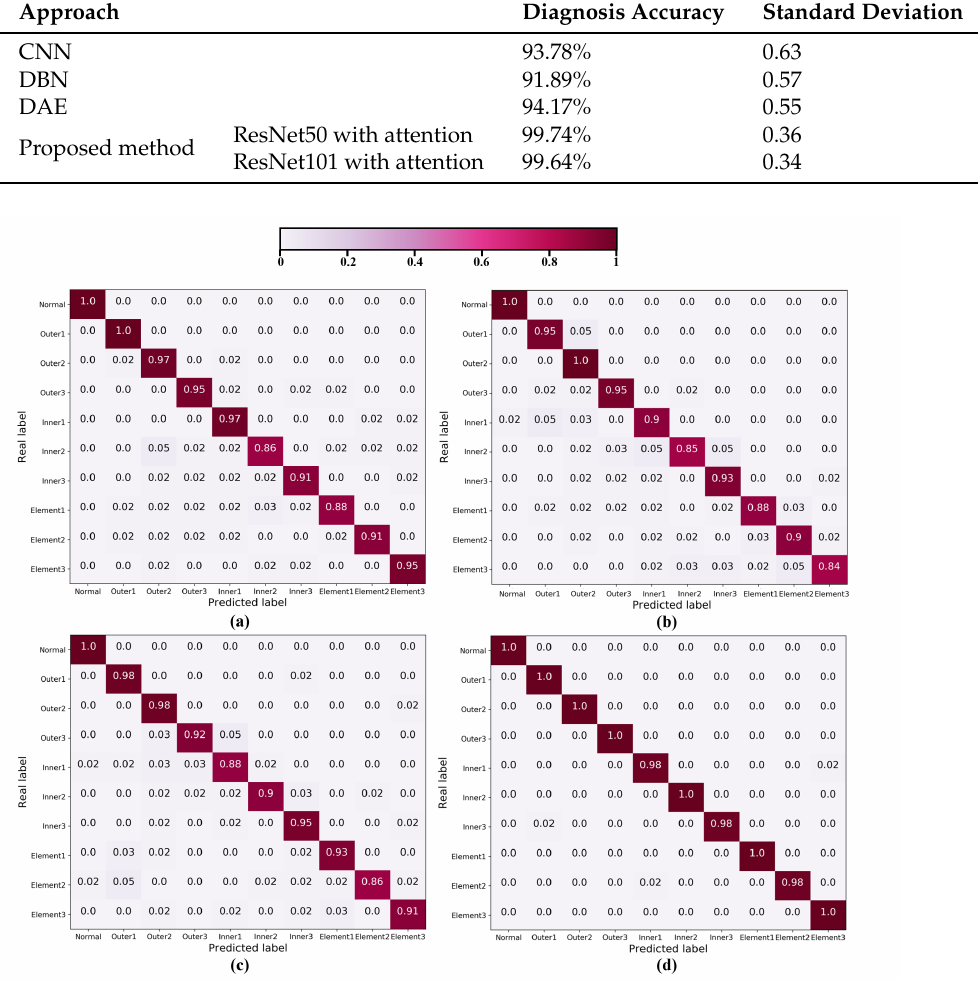
Table 5. Test performance of different methods.